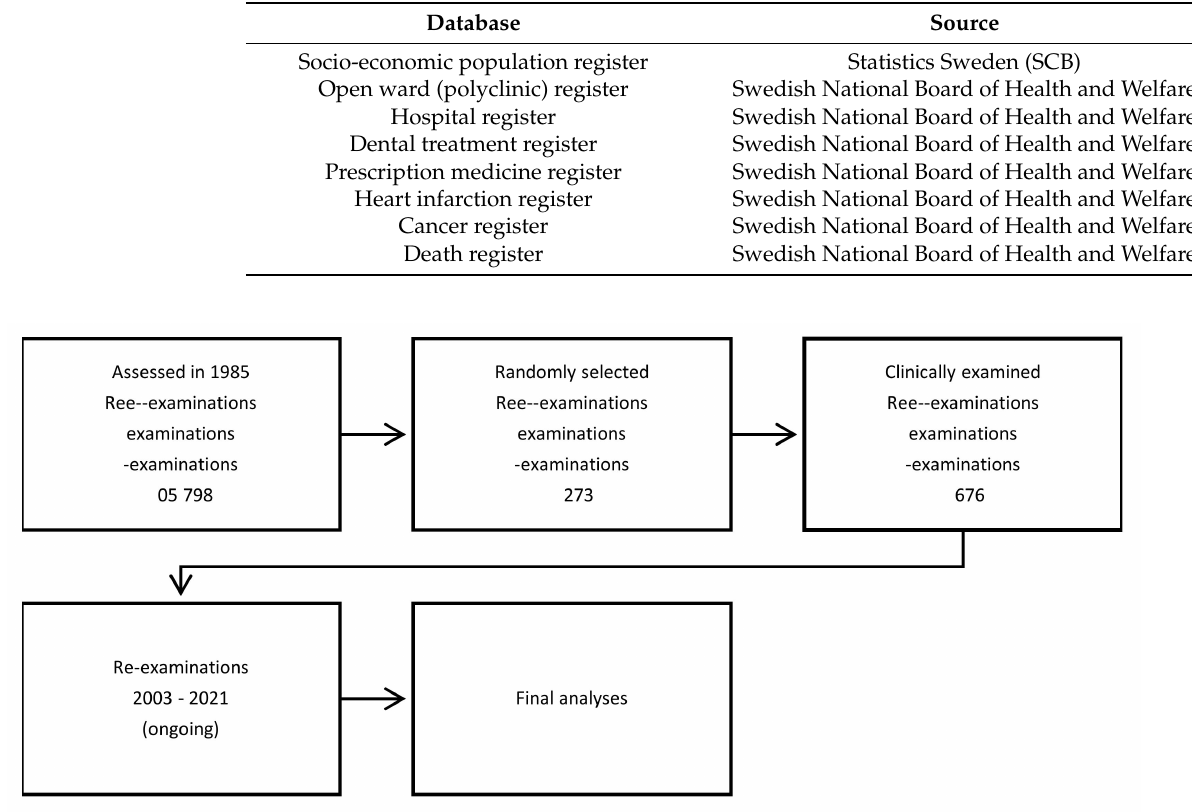
Figure 1. Professor Per-Östen Söder (1928–2020). Table 1. Register databases used in the series of studies.